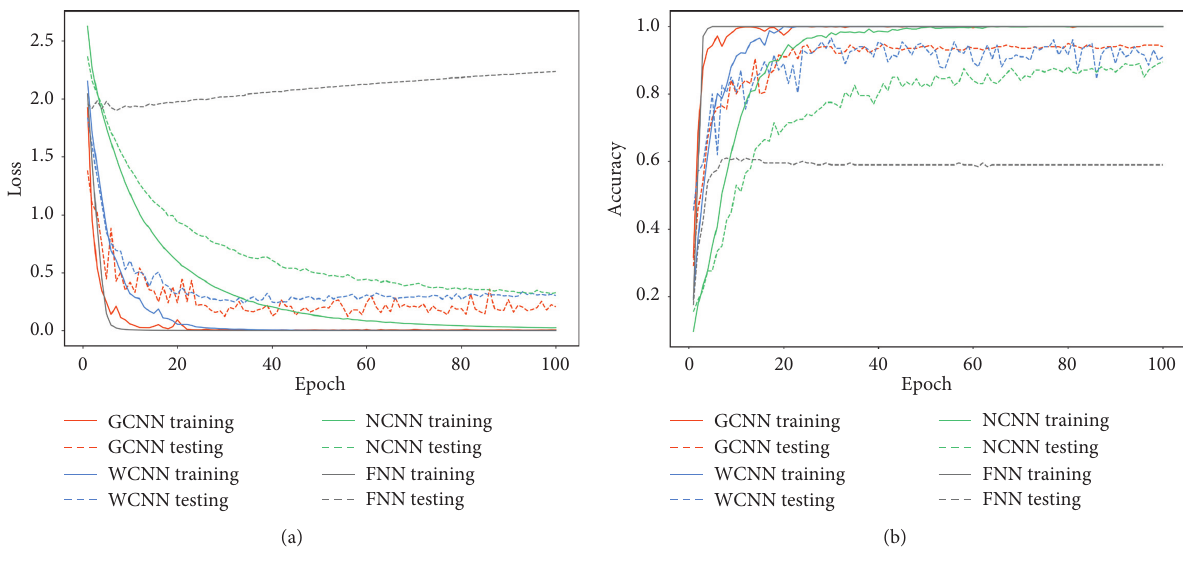
Figure 6: Training and testing accuracies of the models across different scenarios. (a) Training accuracy and (b) testing accuracy.